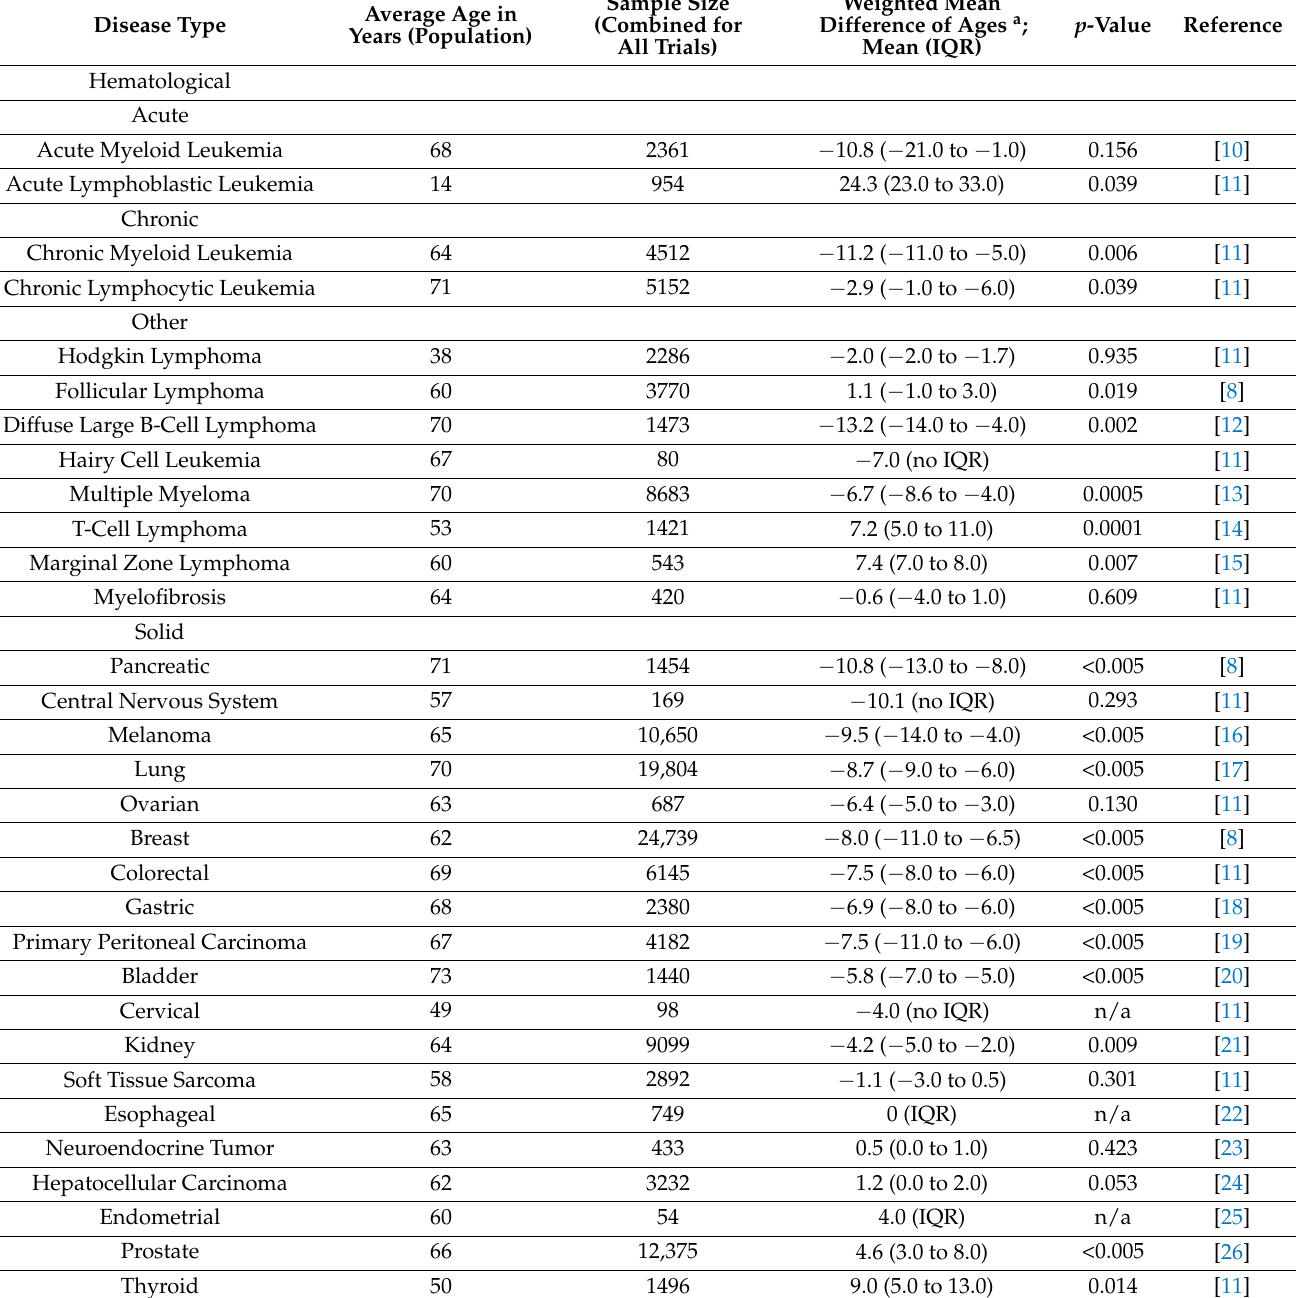
Table 2. Outlining the discrepancy in age between the trial population and actual population. Disease